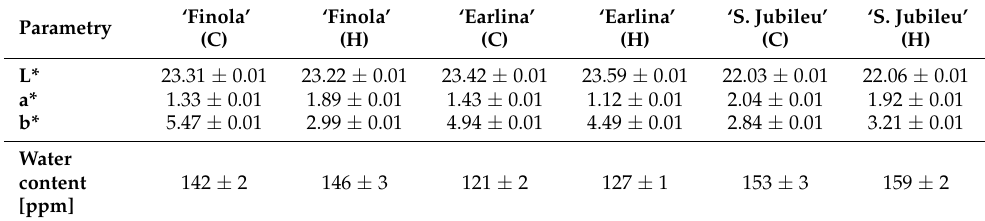
Table 2. Results of color and water content in hemp